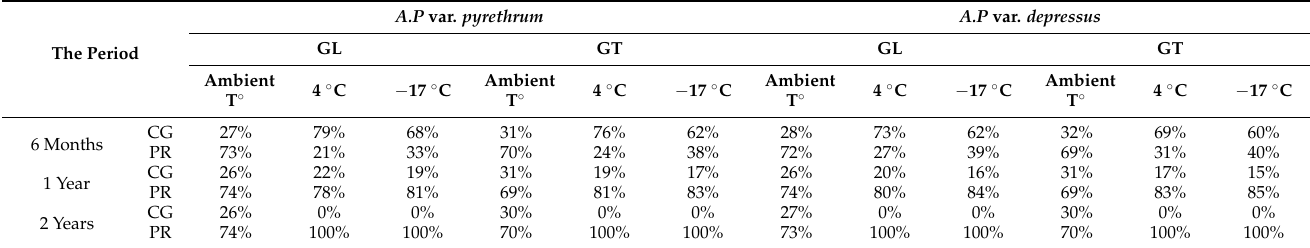
Table 8. Germination characteristics of different types of seeds (GL: peripheral seeds; GT: central seeds) in relation to time and storage